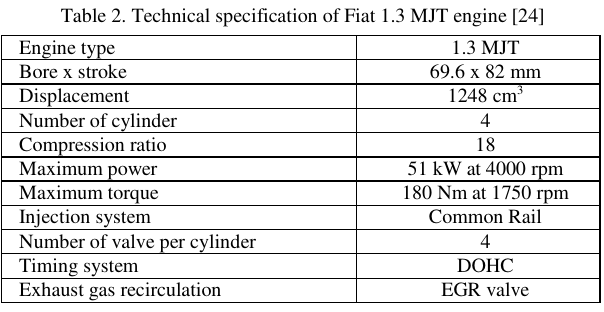
Table 2. Technical specification of Fiat 1.3 MJT engine [24]